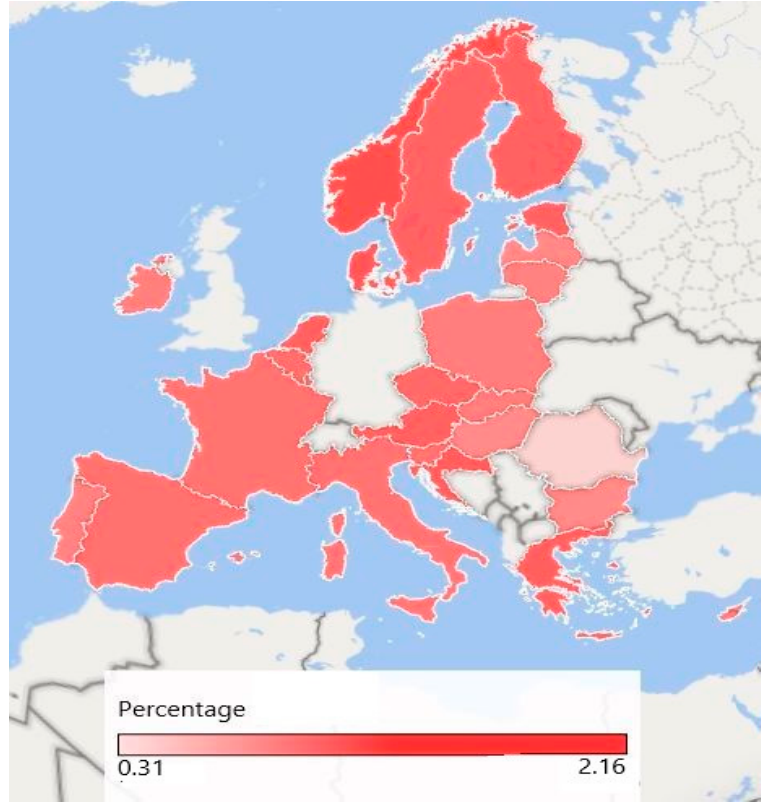
Figure 1. Government budget allocation for R&D expenditures across countries, 2020. Source: Eurostat (Share of GBARD in total general government expenditure).